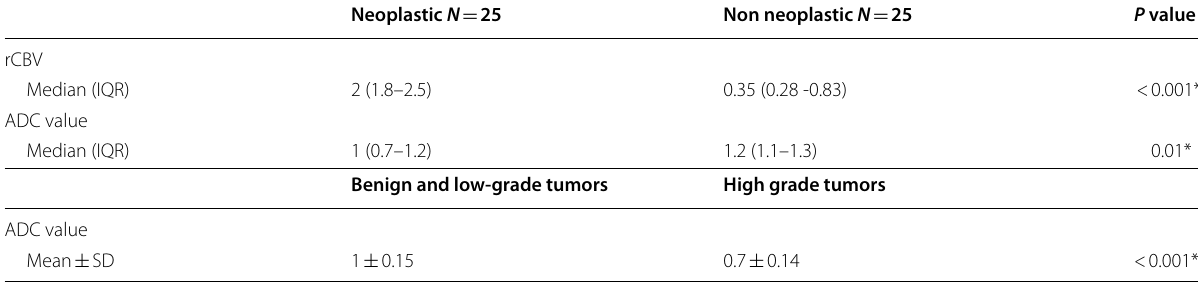
*indicates statistically significant values Table 4 Cutoff value, sensitivity and specificity of rCBV as a predictor of neoplastic lesions